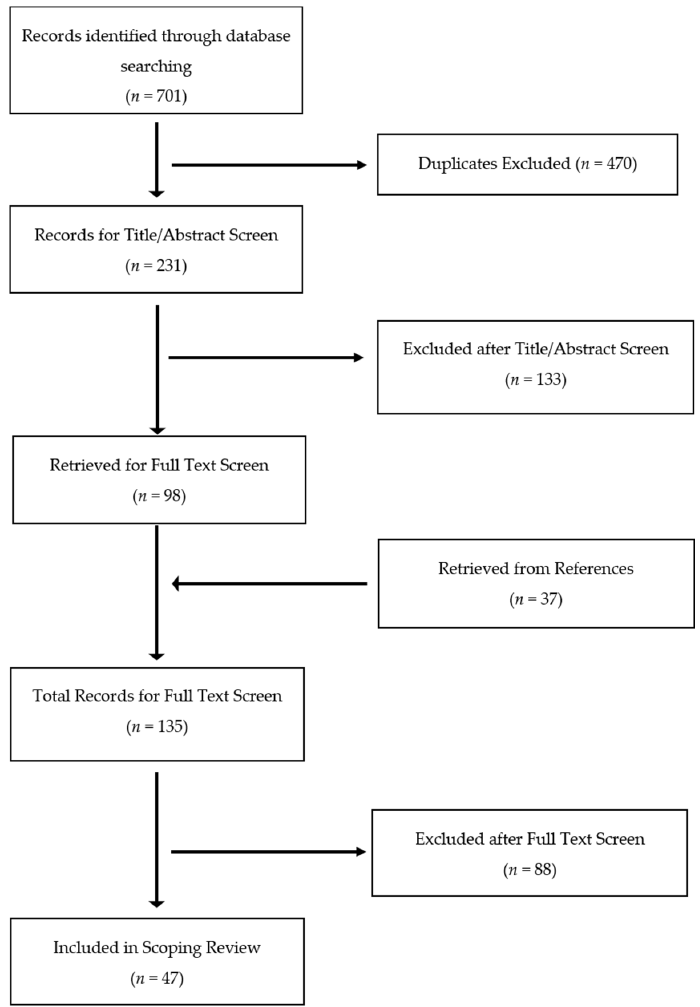
Figure 1. Flow diagram of scoping review article selection.